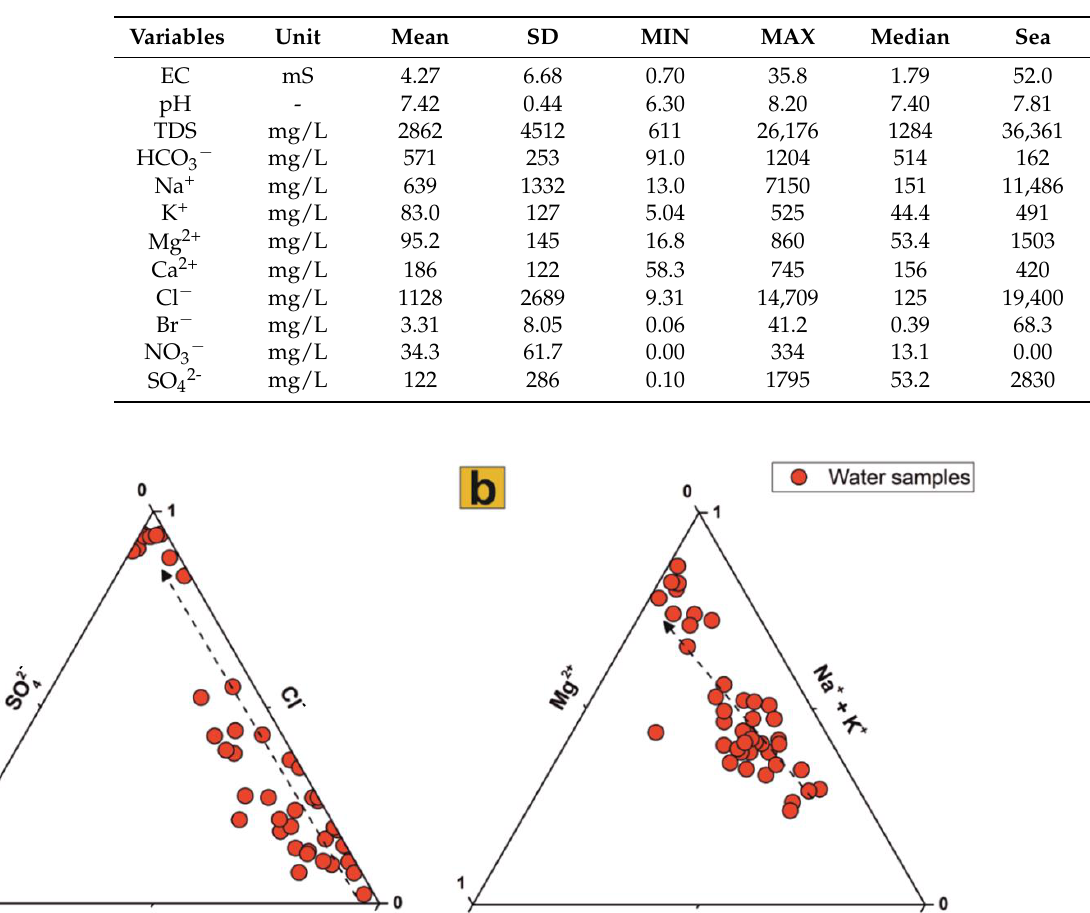
Table 2. General statistics of the sampled waters.